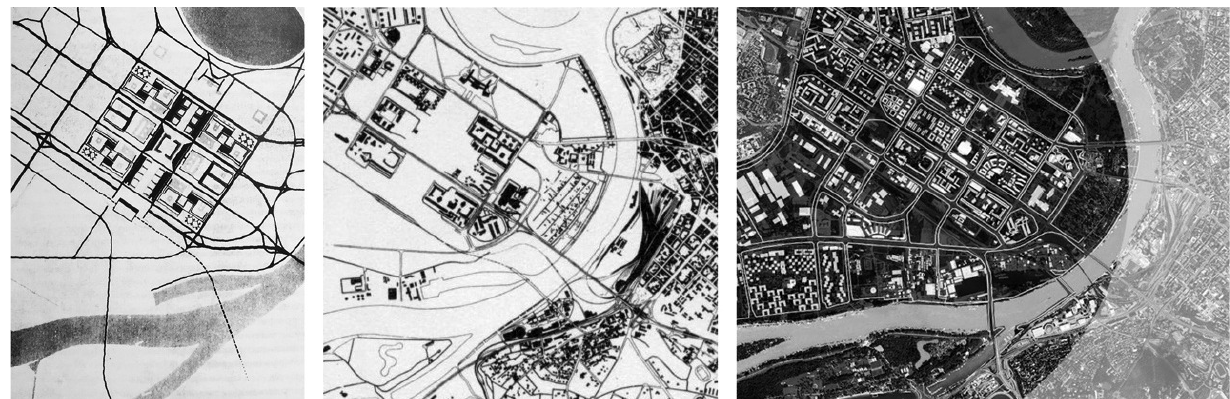
Figure 9. New Belgrade’s urban fabric: The 1960 plan for New Belgrade’s central zone by the Urban Planning Institute’s working group (L. Lenarcic, M. Glavicki, M. Mitic, D. Milenkovic, and U. Martinovic; left); New Belgrade’s urban fabric in 1985 (center); and New Belgrade’s urban fabric in 2018 (right). Sources: Blagojevic (2007, p. 182; left); Perovic (1985, p. 227; center); Anica Dragutinovic, adapted from Bing Maps